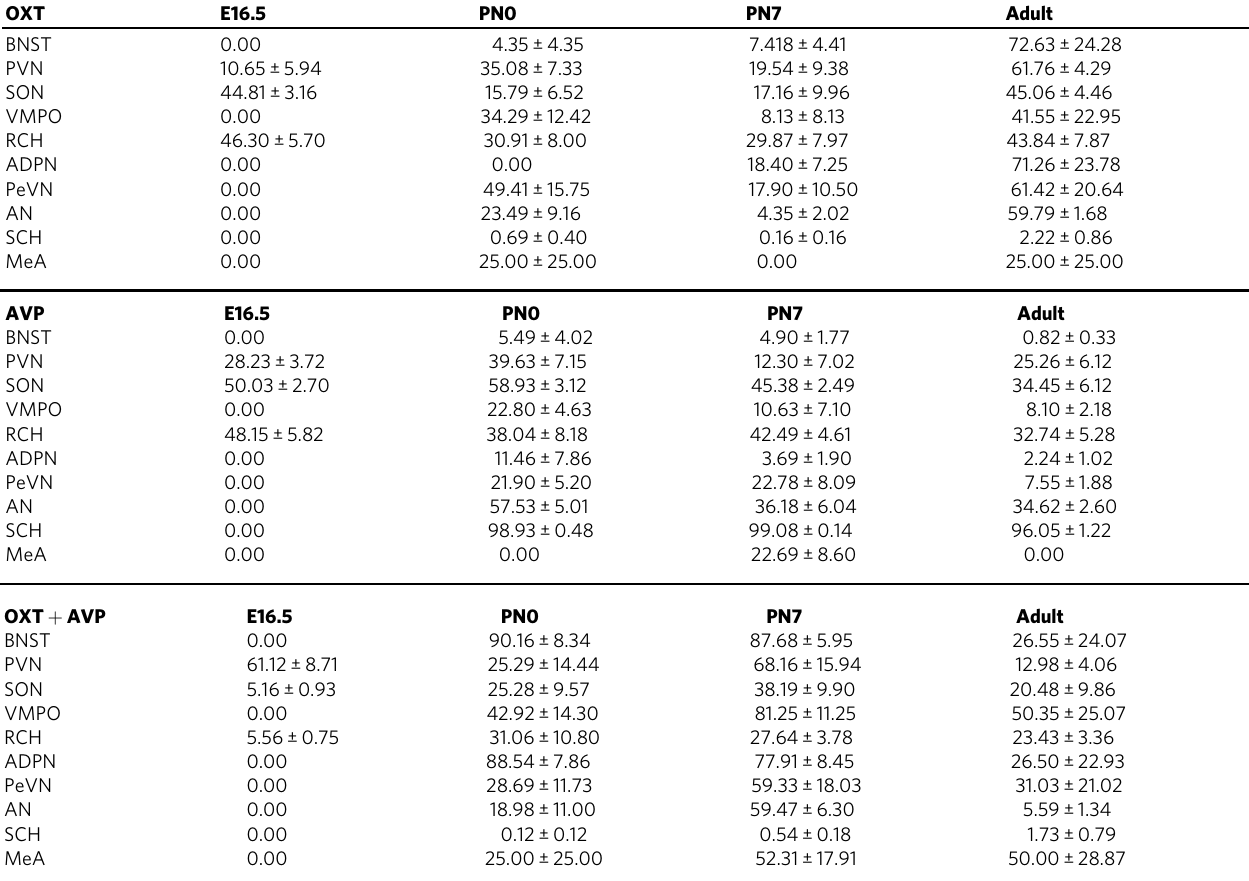
Table 2 Percentage of OXT, AVP, and OXT + AVP neurons in the hypothalamus nuclei during development. OXT